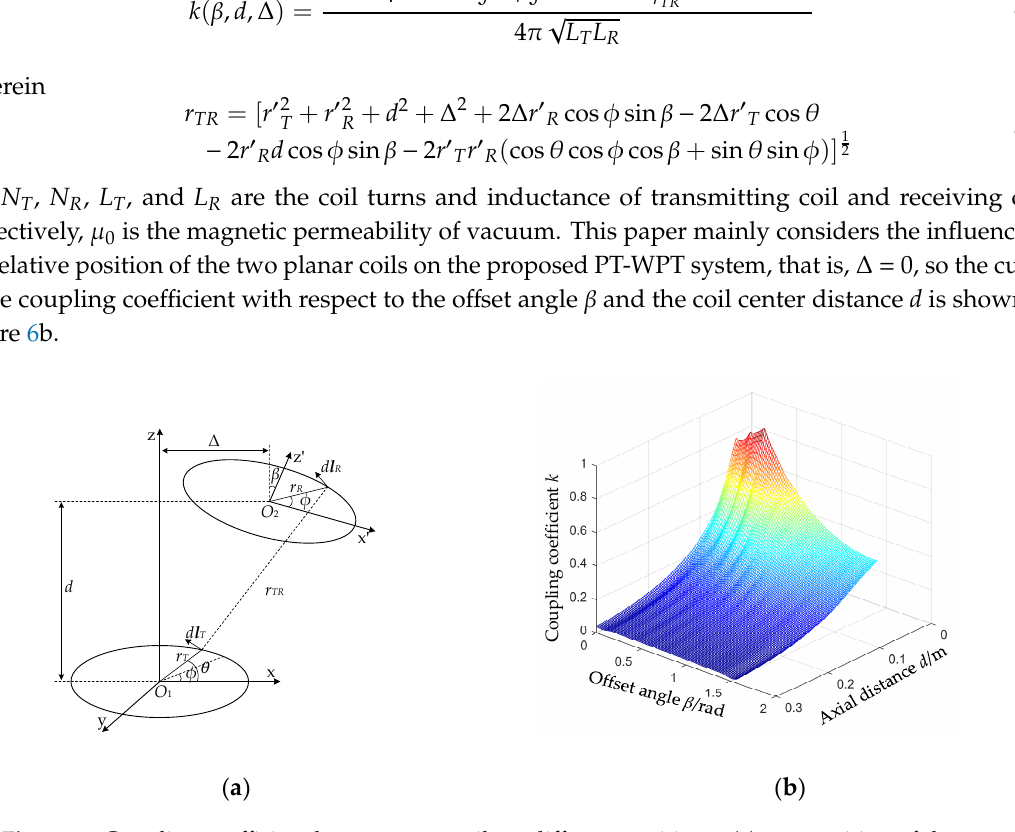
Figure 6. Coupling coefficient between two coils at different positions: ( a ) any position of the two planar coils; ( b ) curve of coupling coefficient, offset angle, and axial distance.